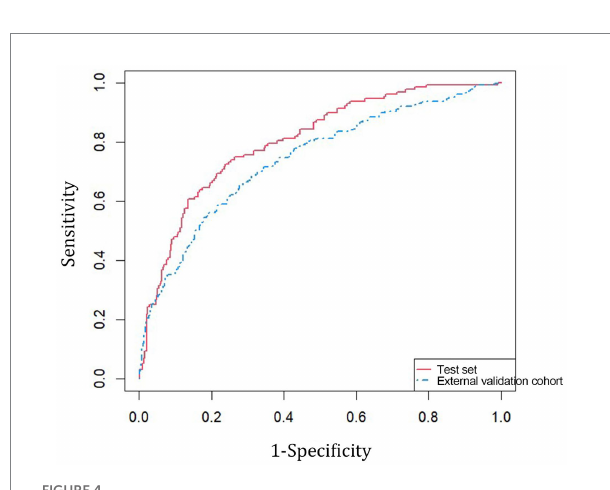
FIGURE 4 Internal and external validation ROC curves of Cox regression model with